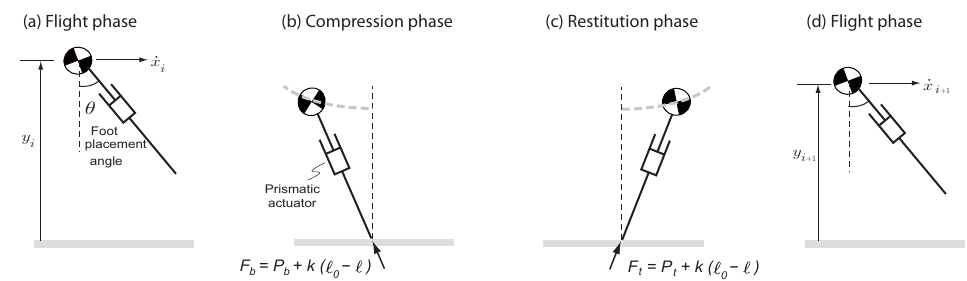
Figure 1. A complete step for the running model. The model starts in ( a ) the flight phase at the apex position (vertical velocity is zero), followed by ( b , c ) the stance phase, and finally ending in ( d ) the flight phase at the apex position of the next step. The running model has a prismatic actuator that is used to provide an axial braking force F b in the compression phase and axial thrust force F t in the restitution phase, and a hip actuator (not shown) that can place the swinging leg at an angle θ with respect to the vertical as the leg lands on the ground. P b , P t , k , and (cid:96) 0 are constant control forces during compression and restitution, the constant gain, and the maximum leg length,